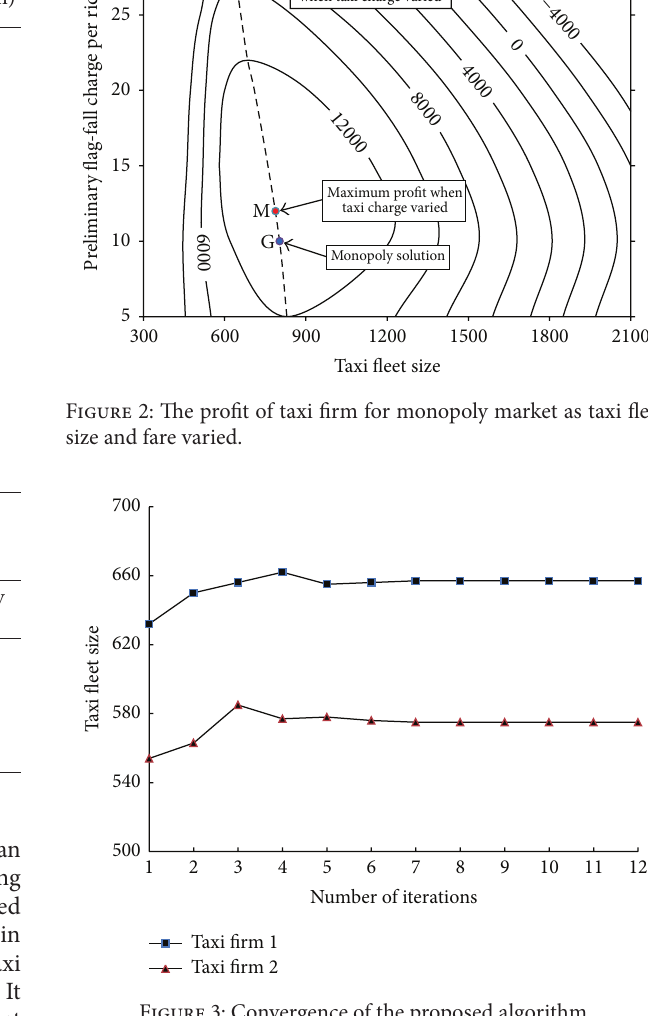
Figure 3: Convergence of the proposed